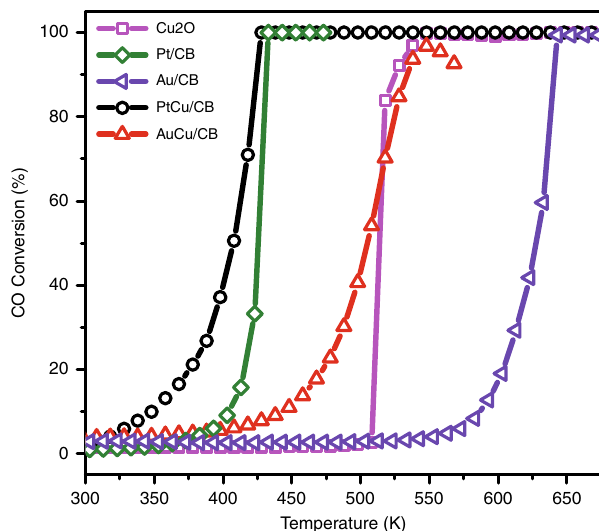
Fig. 5 Catalytic performance of the PtCu/CB, Pt/CB, AuCu/CB, Au/CB and Cu 2 O catalysts. The light-off curves for CO oxidation were obtained under the condition of 1% CO, 20% O 2 , and 79% He. Space velocity was 60,000 mL g − 1 h − 1 from powder catalytic measurements agree with the model studies in the order of: Cu 2 O/Pt > Cu 2 O/Au > Cu 2 O/Ag, which again con fi rmed the activities of Cu 2 O NSs are tuned by OMI.